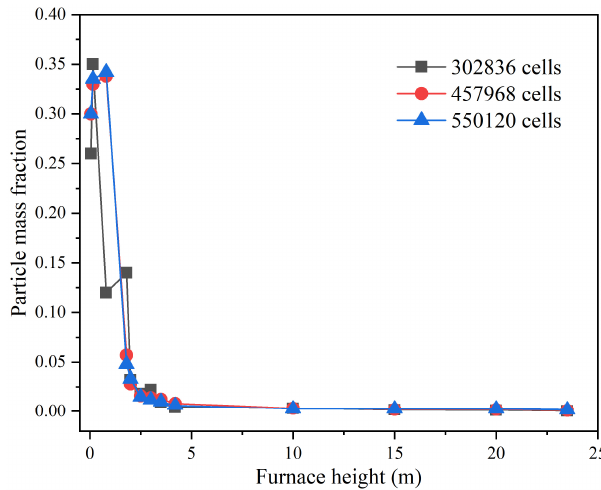
Figure 2. Mesh quality checking of this CFBB.